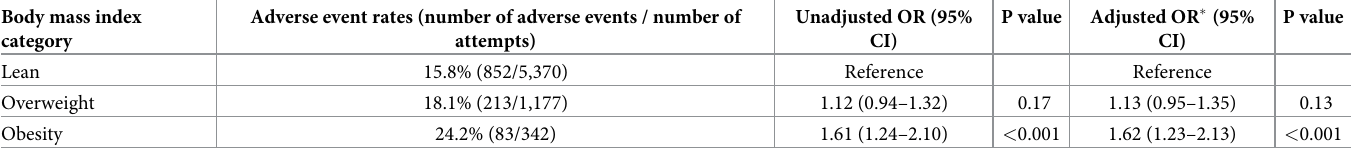
Table 3. Unadjusted and adjusted associations between body mass index and intubation-related adverse events. Body mass index